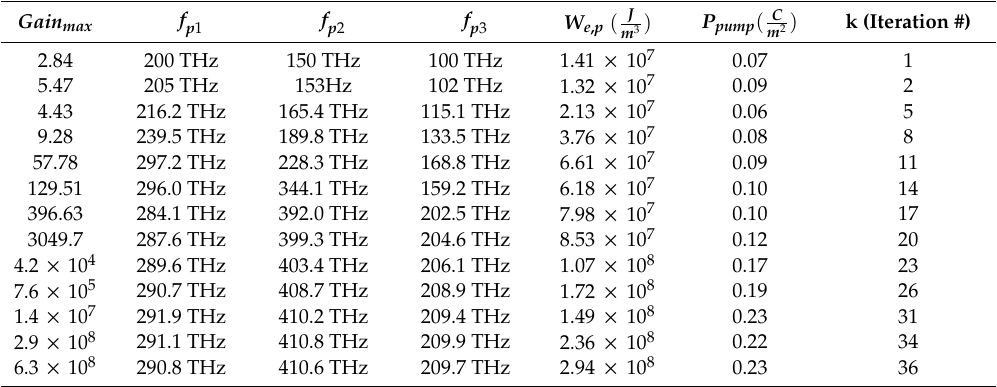
Table 2. BFGS algorithm-based optimization